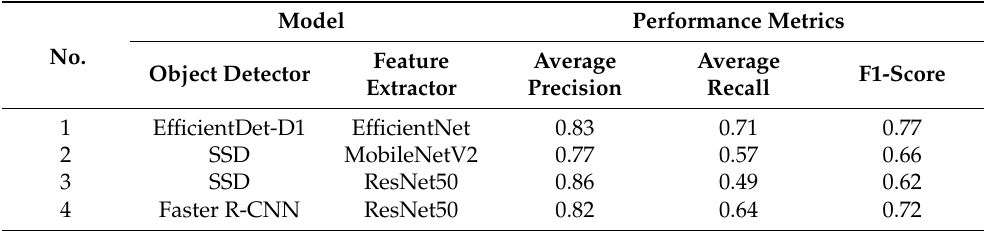
Table 4. The overall performance of the